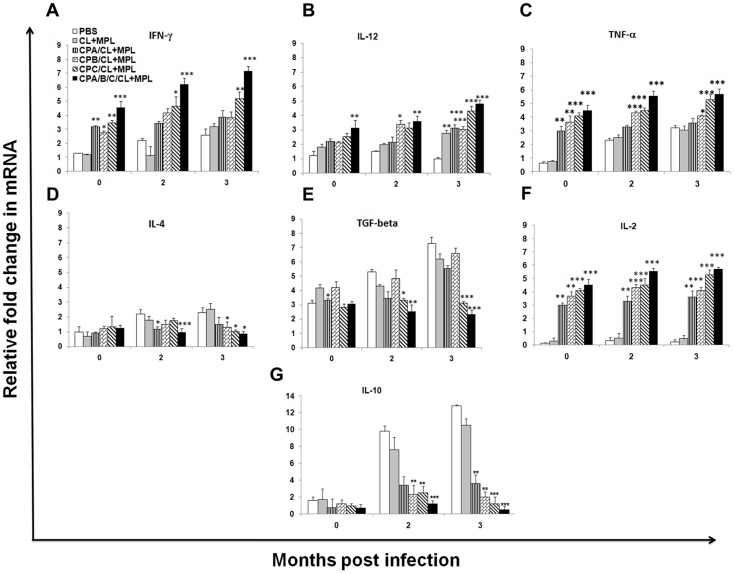
Th1/Th2 cytokine profiles of immunized hamsters at different time intervals pre- and post-infection by quantitative real-time–PCR.Fold change in mRNA expression profiles of A, IFN-γ; B, IL-12; C, TNF-α; D, IL-4; E, TGF-β; F, IL-2; G, IL-10. Each gene was normalized to the housekeeping gene (Hypoxanthine-guanine phosphoribosyltransferase, HGPRT) to avoid variations between different samples. Results are expressed as the mean ± S.E. of five hamsters individually assayed from each group. *, p<0.05; **, p<0.01;***, p<0.001 assessed by one-way ANOVA and Tukey's multiple comparison tests.